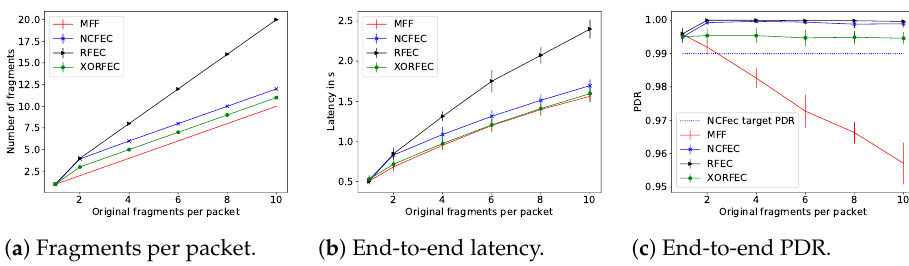
Figure 17. Simulation results for linear topology with link quality of